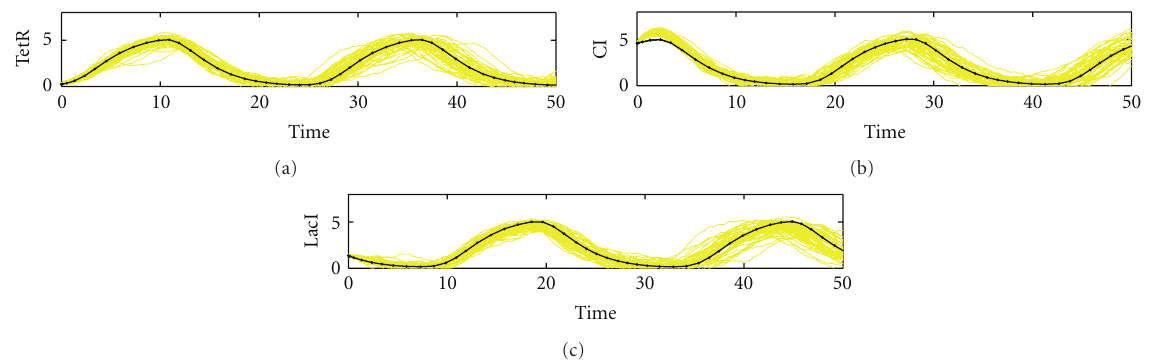
Figure 8: Monte Carlo simulation of biological repressilator by the proposed evolutionary systems biology method. (a) TetR; (b) CI; (c) LacI. The parameters are specified as follows. The standard deviations of uncertain kinetic parameters and decay rates to be robustly tolerated are specified as Δ k 1 = 0 . 2, Δ k 2 = 0 . 2, Δ k 3 = 0 . 2, Δ k 4 = 0 . 02, Δ k 5 = 0 . 02, Δ k 6 = 0 . 02, Δ λ 1 = 0 . 04, Δ λ 2 = 0 . 04, Δ λ 3 = 0 . 04, Δ λ 4 = 0 . 05, Δ λ = 0 . 05, and Δ λ = 0 . 05. The variance of external disturbance v = (0 . 03) 2 . The Monte Carlo simulations are performed by 50 2 5 6 i is σ i rounds. The mean errors e are 0.85, 0.90, and 0.90 with standard deviations of 0.38, 0.38, and 0.37 for TetR, CI, and LacI, respectively.